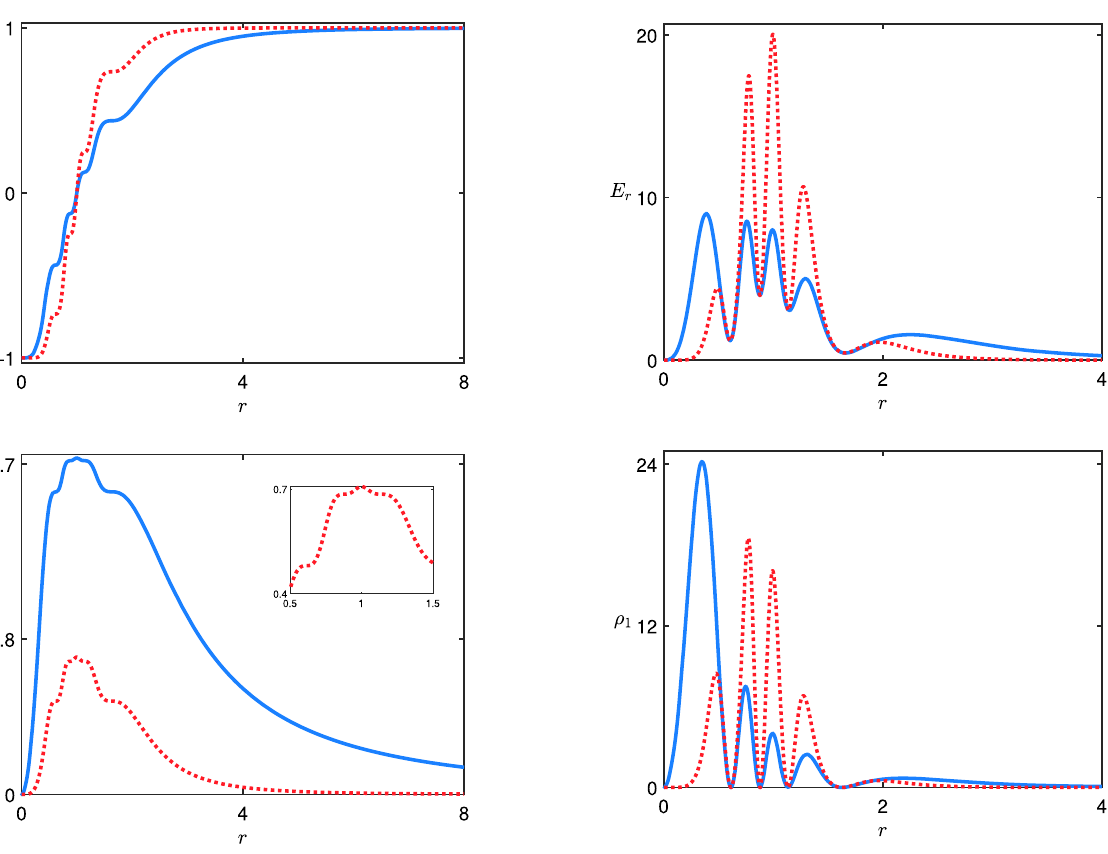
Fig. 11 The solutions φ( r ) (top) and χ( r ) (bottom) associated to the model in Sect. 4.1.2 for σ = 5, α = 2 and n = 2, with k = 1 (solid, blue line) and 2 (dotted, red line). The inset in the bottom figure shows the interval r ∈ [ 0 . 5 , 1 . 5 ] for k = 2